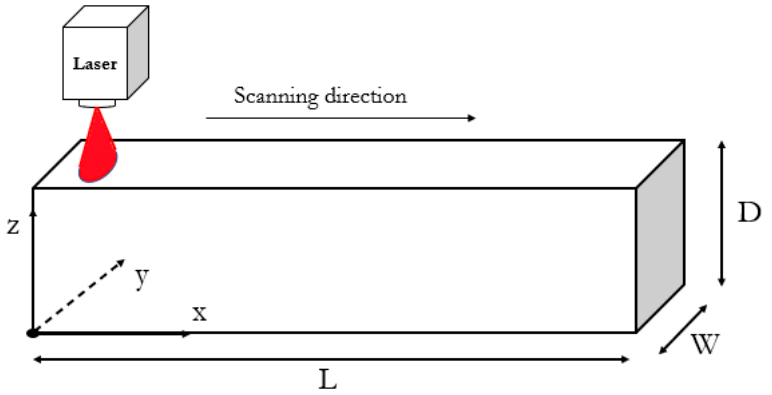
Figure 2. Schematic representation of LST in rectangular samples.